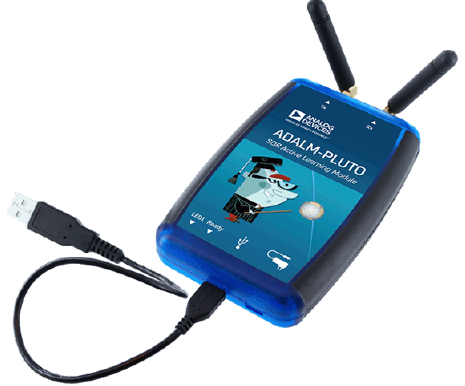
Figure 5. Picture of the “Adalm-PLUTO” SDR device produced by Analog Devices; The image shows the programming and access connector (USB) and the two supplied antennas